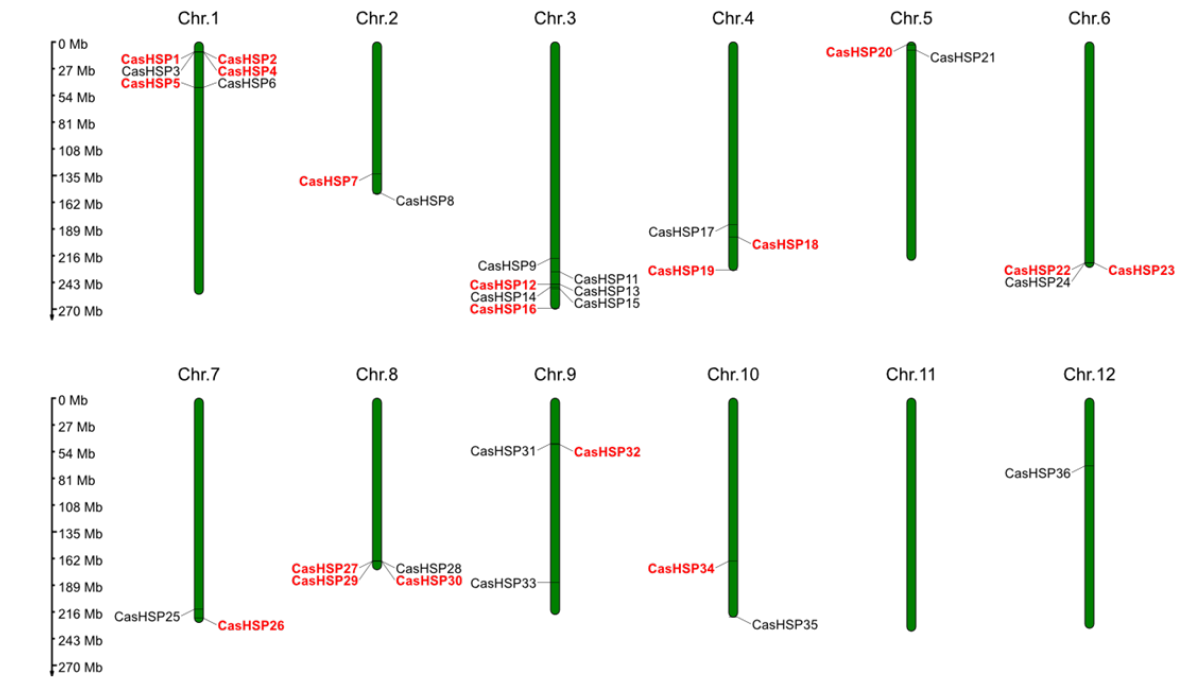
Figure 1. Chromosomal location of the CasHSP genes identified in pepper ( Capsicum annuum L.) genome. The approximate locations of the 41 CasHSP genes among the 12 chromosomes are displayed in each chromosome (Chr.1 – Chr.12). The distribution of the 19 CasHSP genes specifically detected in the sweet pepper fruit transcriptome is highlighted in red. Chr., chromosome.